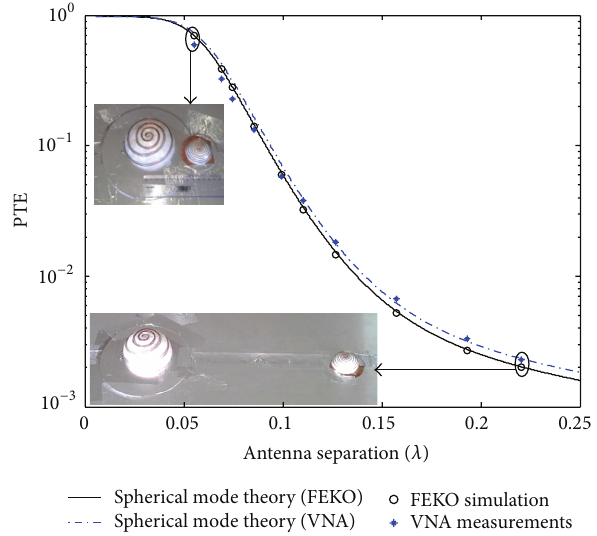
Figure 13: PTE measured between the two different SHAs and comparison between simulation and